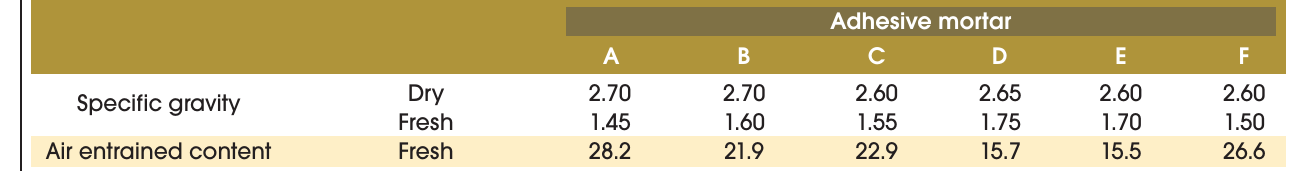
Adhesive mortar